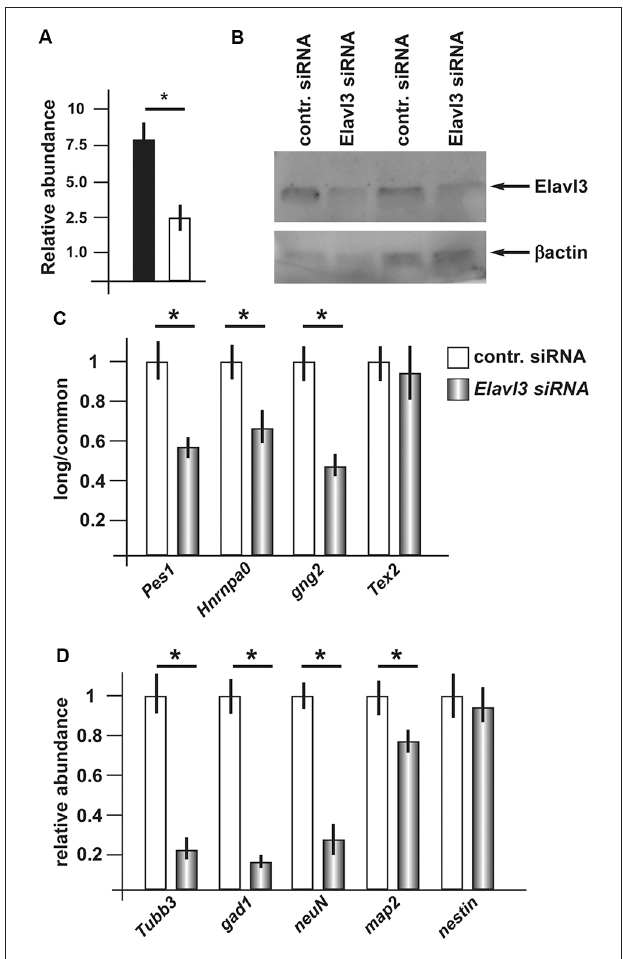
FIGURE 4 | Effect of depletion of Elavl3 in differentiating ANS cells. (A) RealTime qPCR analysis to detect the abundance of Elavl3 mRNA in ANS cells treated with the control (black) or anti-Elavl3 (white) siRNA. (B) Western blot analysis of ANS cells treated with the control siRNA or with the anti-Elavl3 siRNA, to confirm the downmodulation of Elavl3 protein (top). Staining with anti-actin on the same blot is used as loading control (bottom). (C) Real Time qPCR analysis to detect the relative abundance of the longer vs. the common variants of Pes1 , Hnrnpa0 , Gng2 and Tex2 mRNAs, comparing siRNA-treated vs. control-treated ANS cells, maintained in differentiation conditions. (D) Real-Time qPCR analysis to detect the mRNA abundance of the differentiation genes GAD1, Tub β 3, NeuN and Map2 in ANS cells treated with the control (black bars) or anti- Elavl3 (open bars) siRNA. ∗ p <